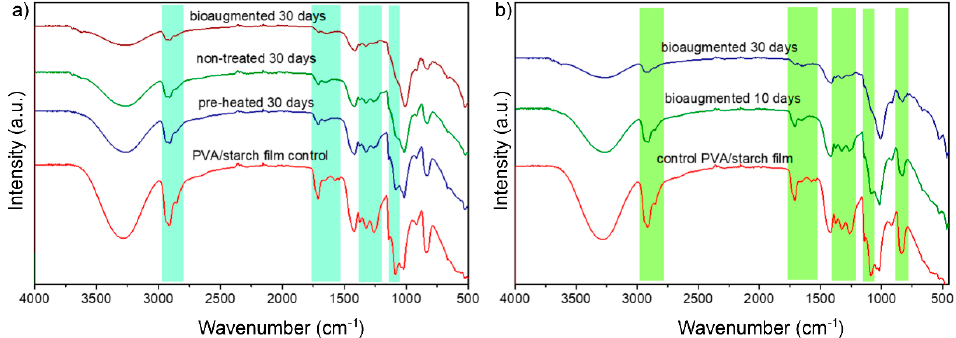
Figure 6. FTIR analysis of ( a ) degraded films after 30 days in different model composting systems, and ( b ) degraded films in bioaugmented composting system over time.